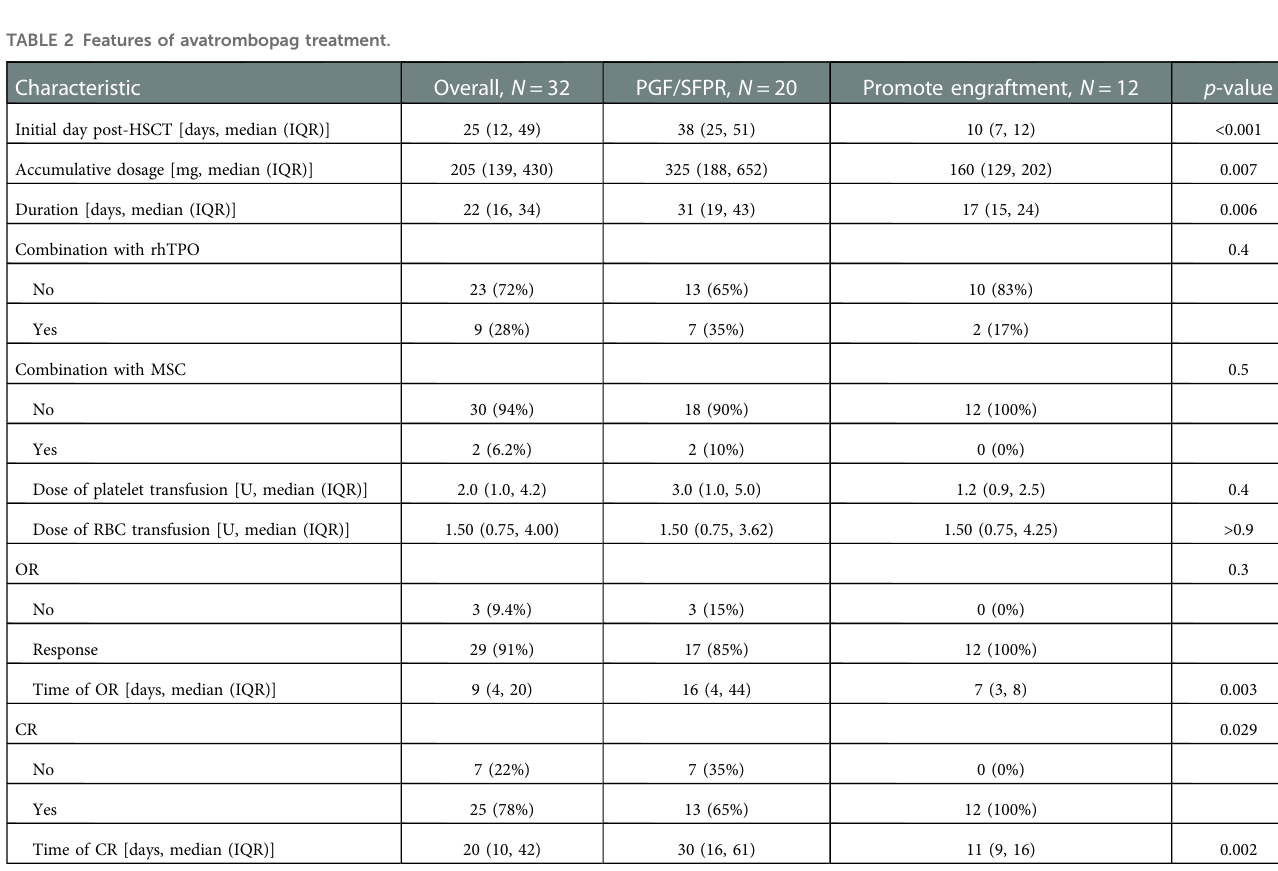
TABLE 2 Features of avatrombopag